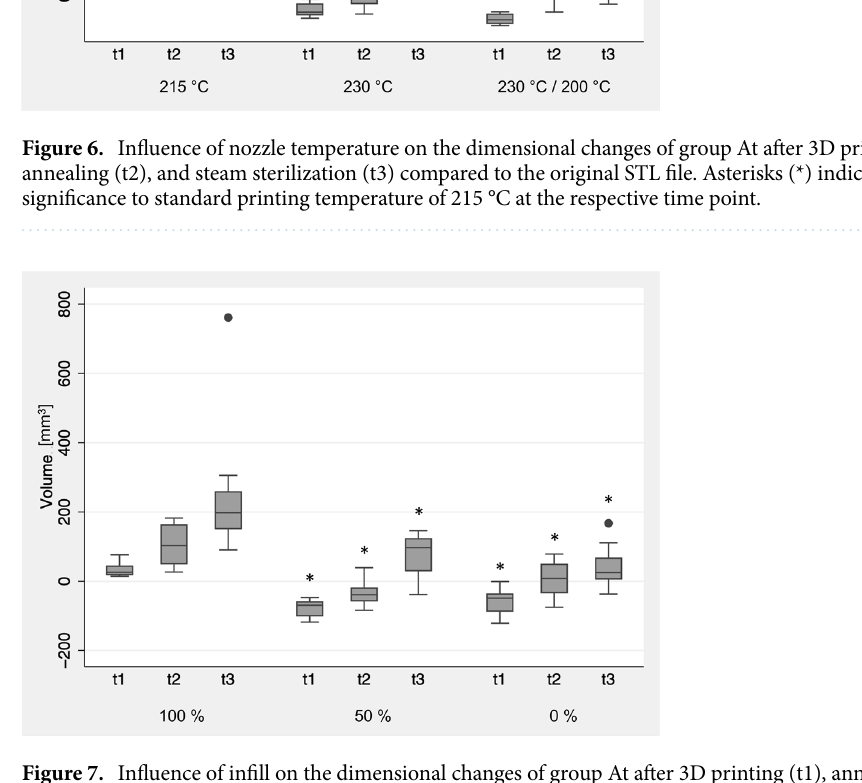
Figure 7. Influence of infill on the dimensional changes of group At after 3D printing (t1), annealing (t2), and steam sterilization (t3) compared to the original STL file. Asterisks (*) indicate significance to standard printing infill of 100% at the respective time